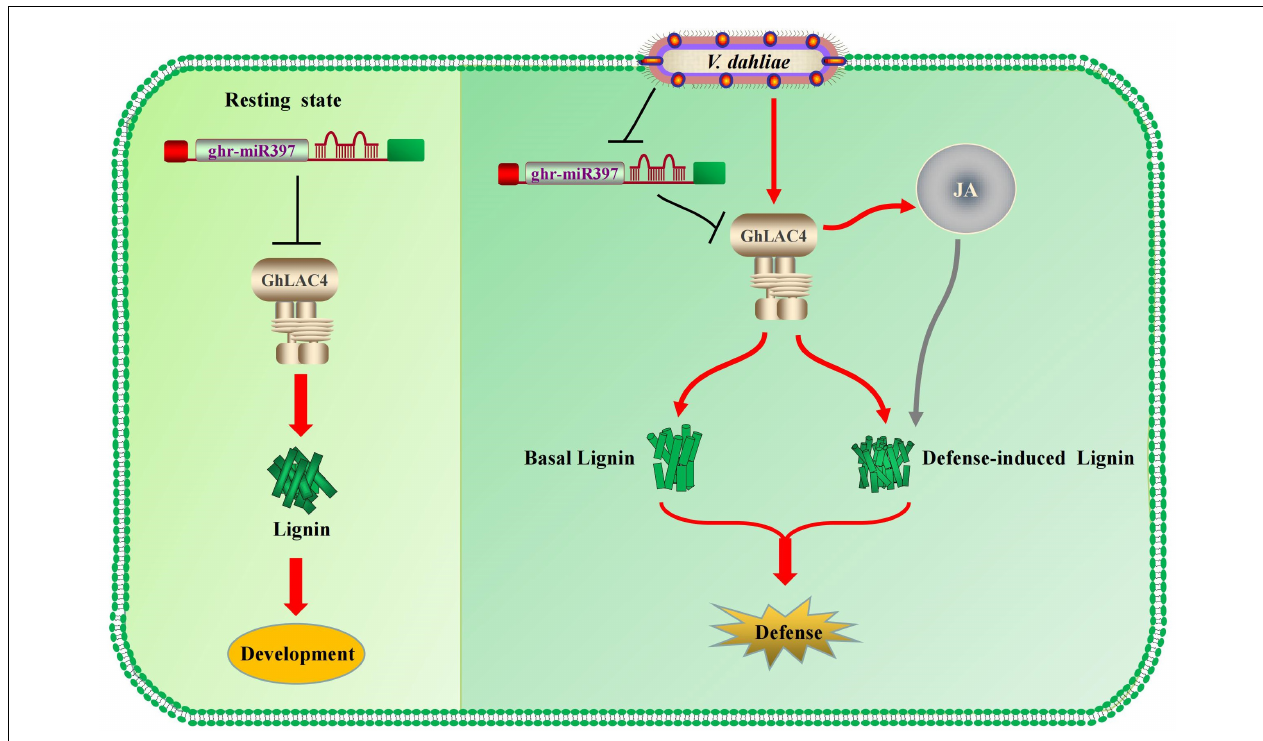
FIGURE 8 | The cotton miR397-LAC4 module working pattern diagram. In resting state, GhLAC4 normally acts in lignin biosynthesis (Left) . As infected by V. dahliae , the ghr-miR397-GhLAC4 module can mediate lignin accumulation through basal lignin biosynthesis and defence-induced lignin biosynthesis to increase plant defence (Right)